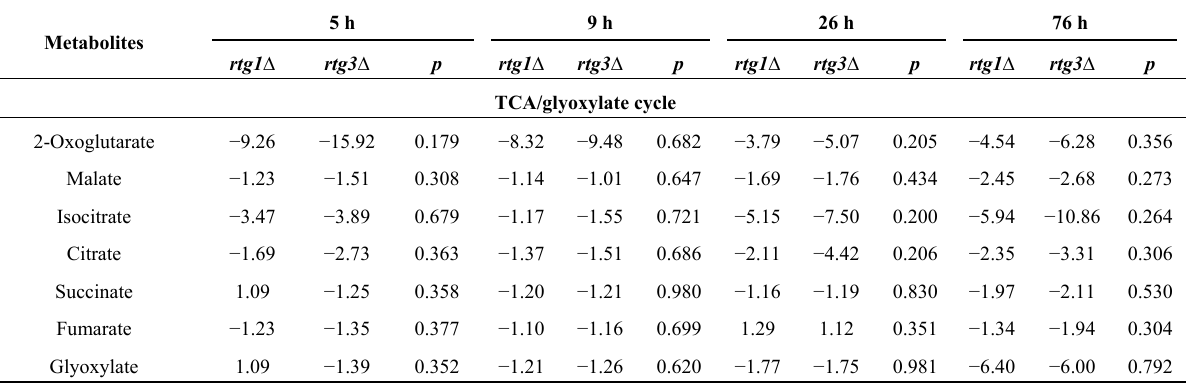
Table 1. Metabolite fold-change for the 50 most important metabolites for the rtg1 ∆ and rtg3 ∆ strains relative to wild-type strain BY4742 at each sampling time (inversed in the case of downregulation). Bold values indicate a statistically significant difference between rtg1 ∆ and rtg3 ∆ ( p < 0.05, determined by a two-tailed heteroscedastic t -test and corrected for multiple testing (Benjamini and Hochberg false discovery rate,